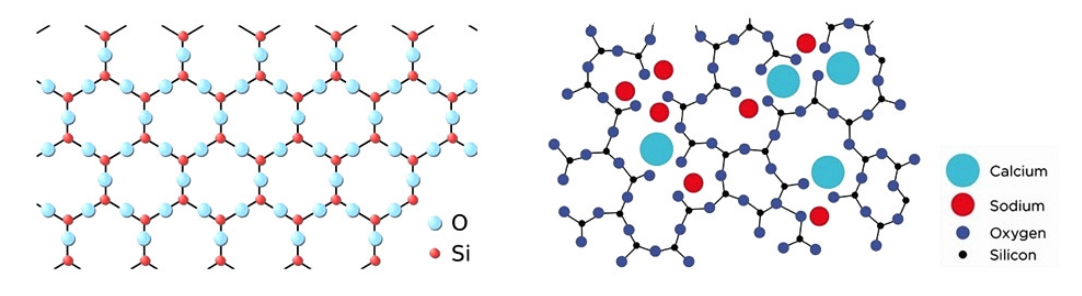
Figure 3: The ordered crystal lattice of silica (left) typical of minerals, and random lattice (right) typical of glass, with the addi- tion of fluxes (sodium) and stabilizers (calcium). From the public